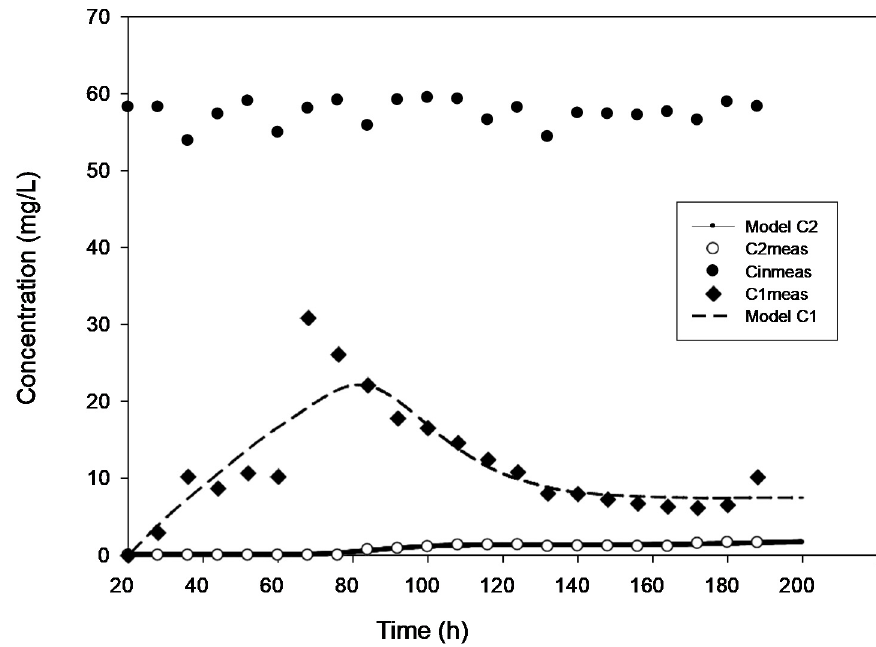
Figure 1. Model validation for the concentration of 50 mg·L − 1 .